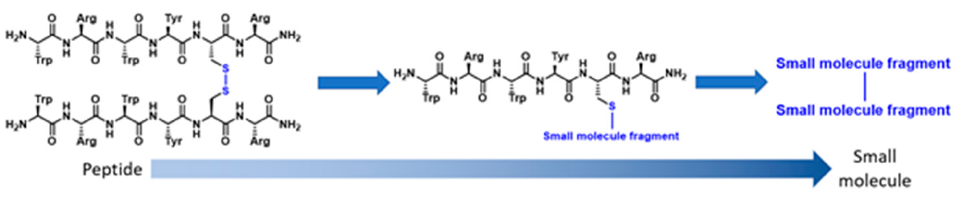
Figure 41. The use of Peptide-Directed Ligand Design for the development of novel small molecule 4WJ binders, from the known dimeric peptide 4WJ binder WRWYCR.